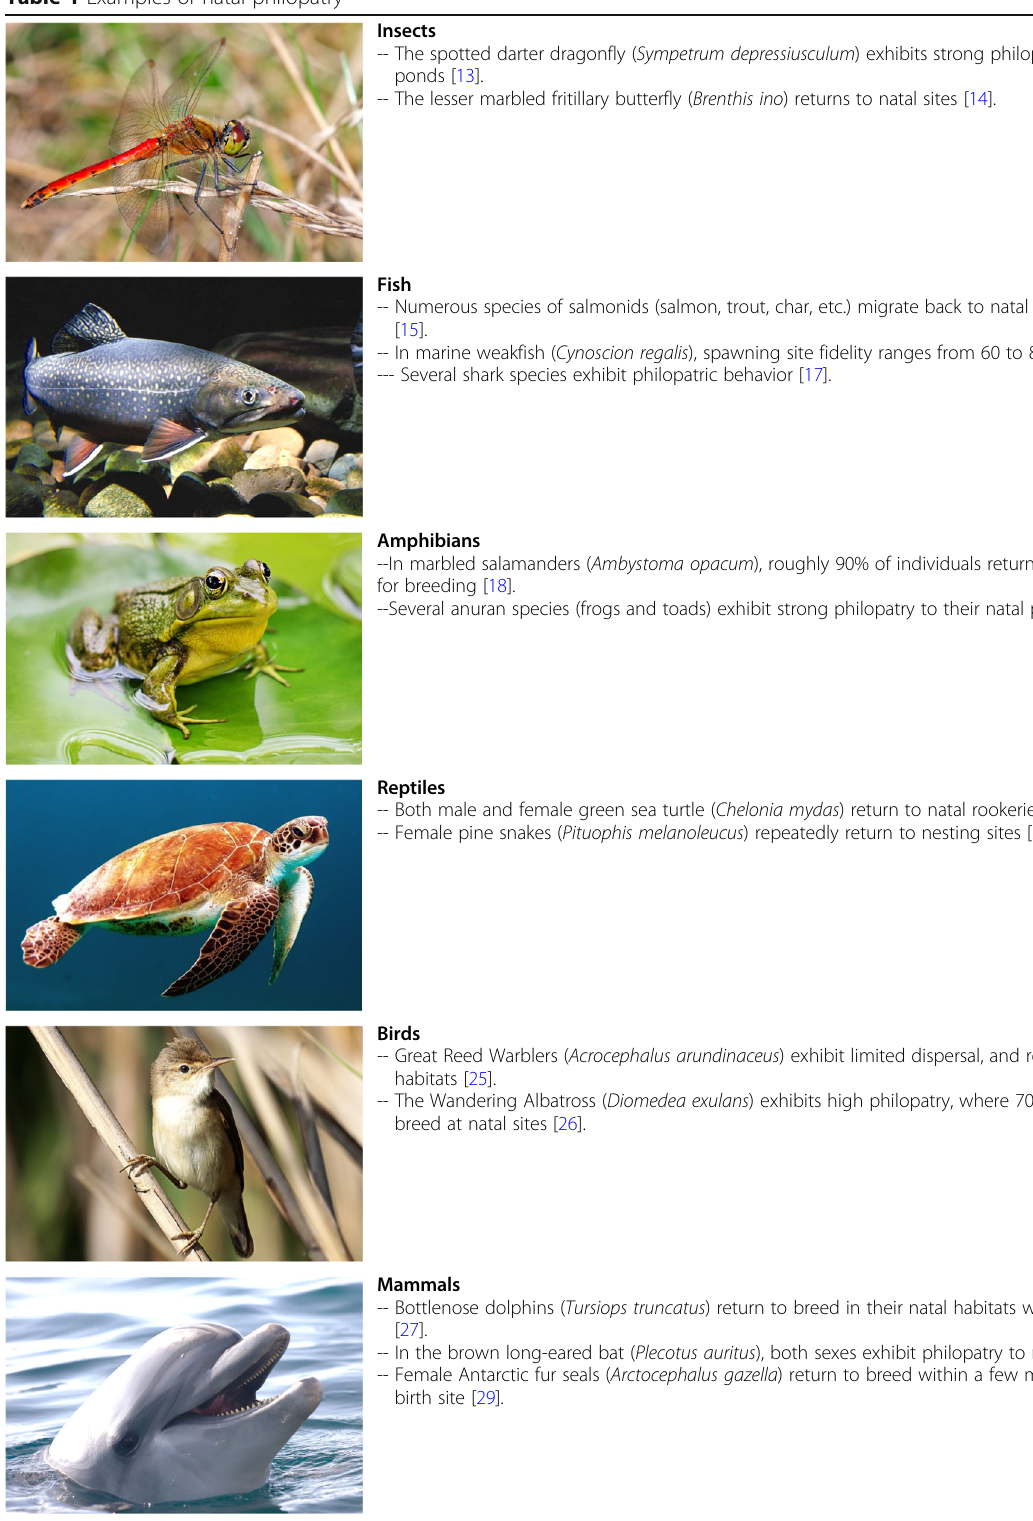
Table 1 Examples of natal